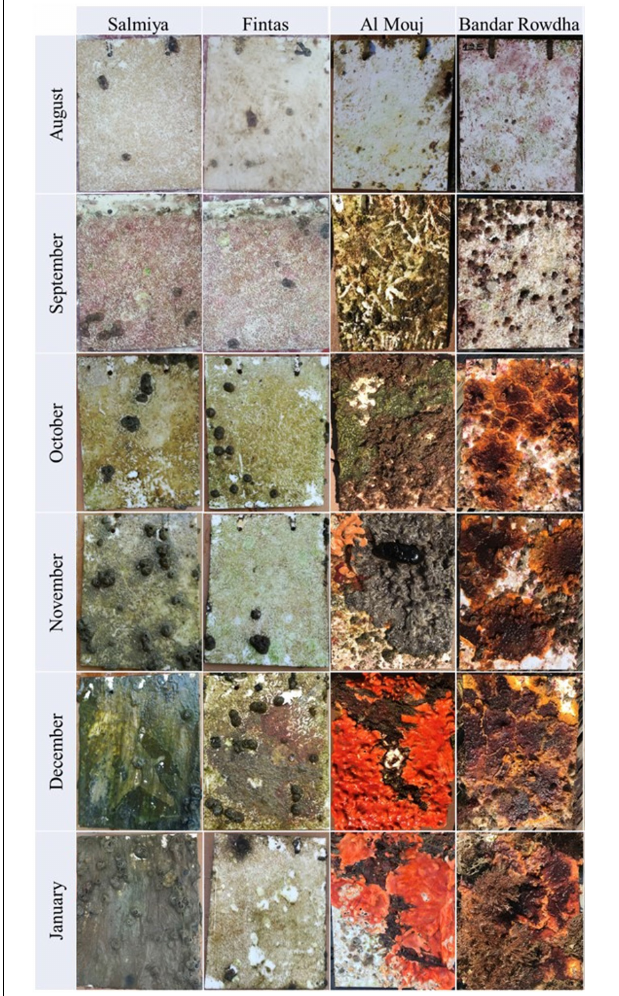
FIGURE 1 | Development of mature biofouling community on acrylic panels at the sampling locations in Kuwait (Fintas and Salmiya) and Oman (Bandar Rowdha and Al Mouj) during the sampling period of 6 months from August 2017 to January